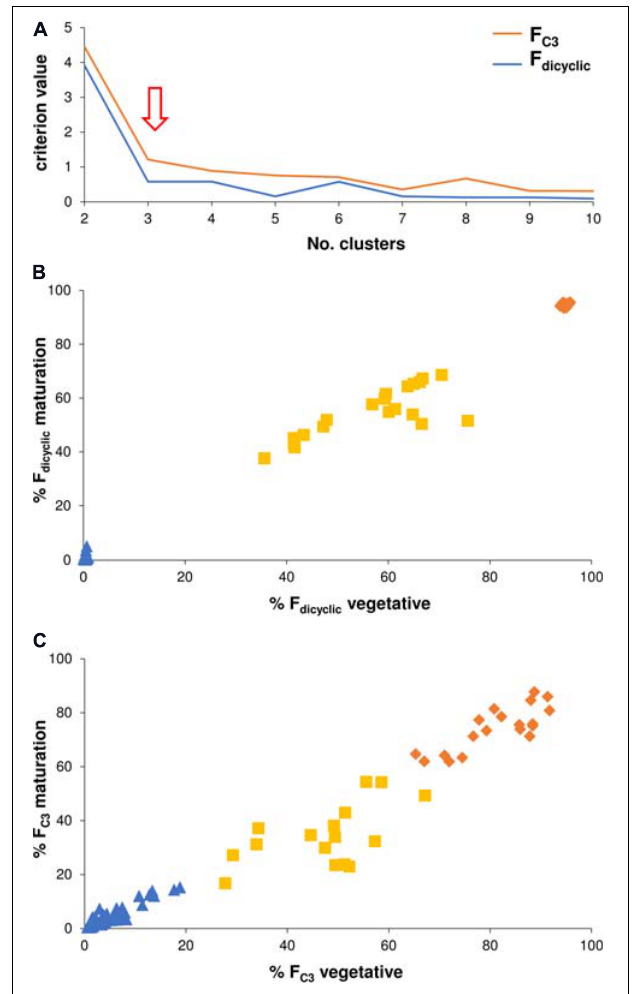
FIGURE 5 | (A) Non-hierarchical k -means cluster analysis criterion values as a function of clusters. (B) Non-hierarchical k -means tripartite cluster analysis for the F dicyclic chemotypic values across vegetative and maturation developmental stages. (C) Non-hierarchical k -means tripartite cluster analysis for the F C3 values across vegetative and maturation developmental stages. Red arrow indicates optimal number of clusters for the F dicyclic as well as the F C3 chemotypic values; Blue triangle indicates low cannabinoid fraction cluster; Yellow square indicates intermediate cannabinoid fraction cluster; Orange diamond indicates high cannabinoid fraction cluster; C 3 -alkyl cannabinoid fractions (F C3 ); C 5 -alkyl cannabinoid fractions (F C5 ); and dicyclic cannabinoid fractions (F dicyclic